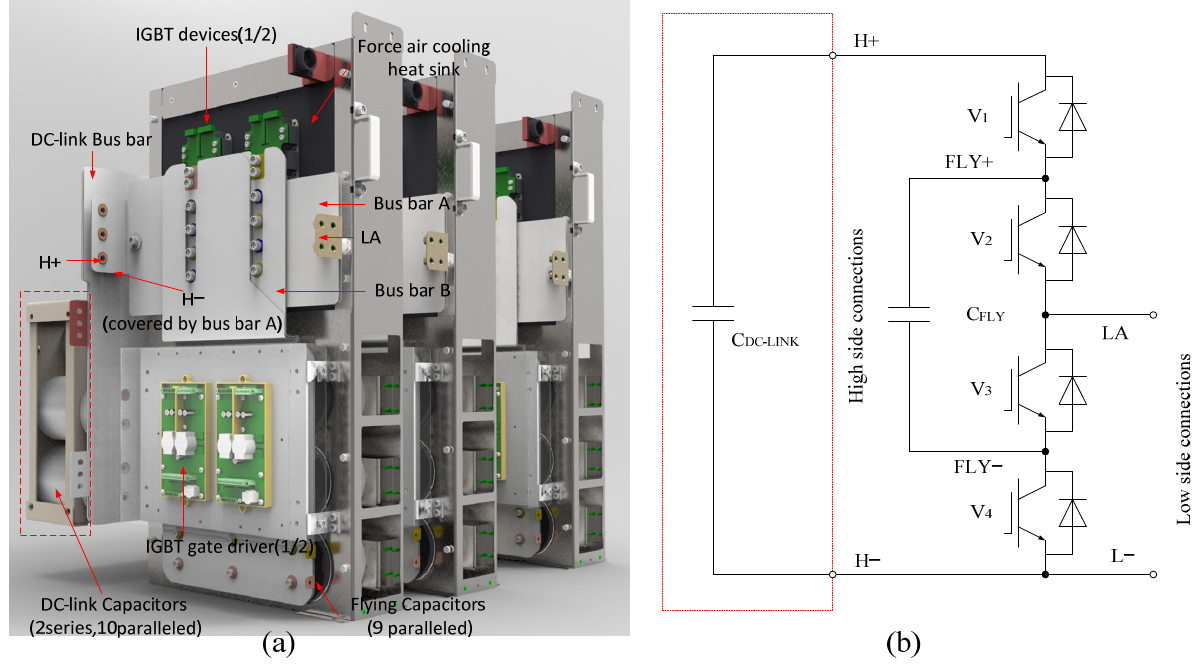
Figure 8. Three FC ‐ 3L ‐ BDC phase ‐ leg PEBBs and DC_link capacitors. ( a ) Three ‐ dimensional mod ‐ Figure 8. Three FC-3L-BDC phase-leg PEBBs and DC_link capacitors. ( a ) Three-dimensional models. els. ( b ) Simplified electrical scheme of single FC ‐ 3L ‐ BDC phase ‐ leg PEBB. ( b ) Simplified electrical scheme of single FC-3L-BDC phase-leg